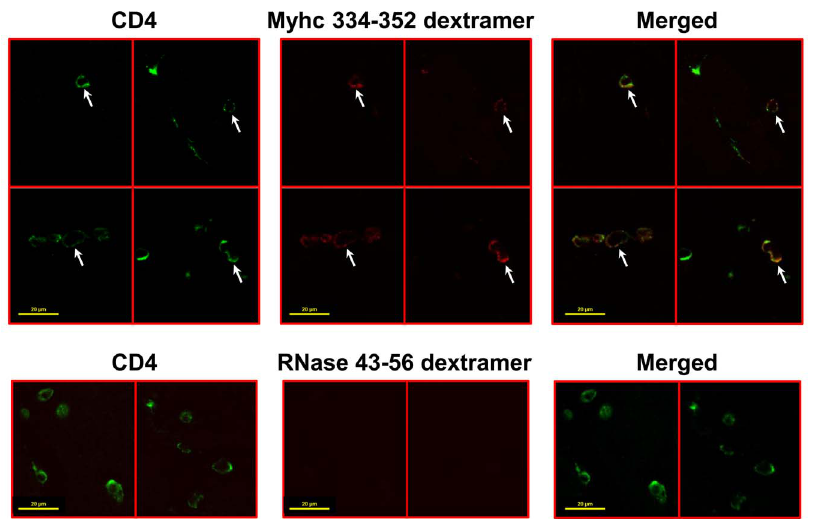
Figure 4. Detection of cardiac myosin-specific CD4 T cells by insitu staining. EAM was induced in A/J mice by immunizing the animals with Myhc 334–352 in CFA; at termination on day 21, hearts were collected after perfusion, and the tissue blocks were prepared using 4% PBS-buffered agarose. Eight paired sections of 200 m m thickness each were made using vibratome. One section from each pair (a total of eight sections) were stained with mixtures containing either Myhc 334–352 dextramers/anti-CD4 or RNase 43–56 (control) dextramers/anti-CD4. After fixing with 4% PBS- buffered paraformaldehyde, the sections were washed and mounted for examination by LSCM. A collage of images showing the cells positive for both dextramers and CD4 or CD4 alone is shown. Top panels: sections stained with Myhc 334–352 dextramers and anti-CD4. Bottom panels: sections stained with RNase 43–56 dextramers and anti-CD4. Left panel: CD4, green; middle panel: dextramers, red; right panel: merged. (arrows, dext + CD4 + T cells). Original magnification 1000 6 ; bar =20 m m.